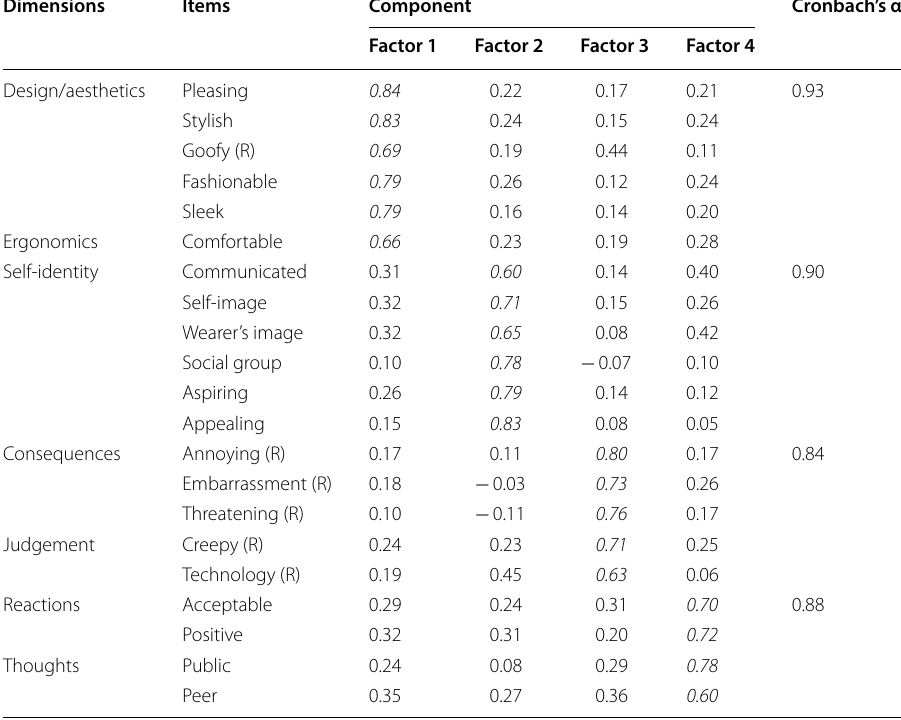
R, reverse coding